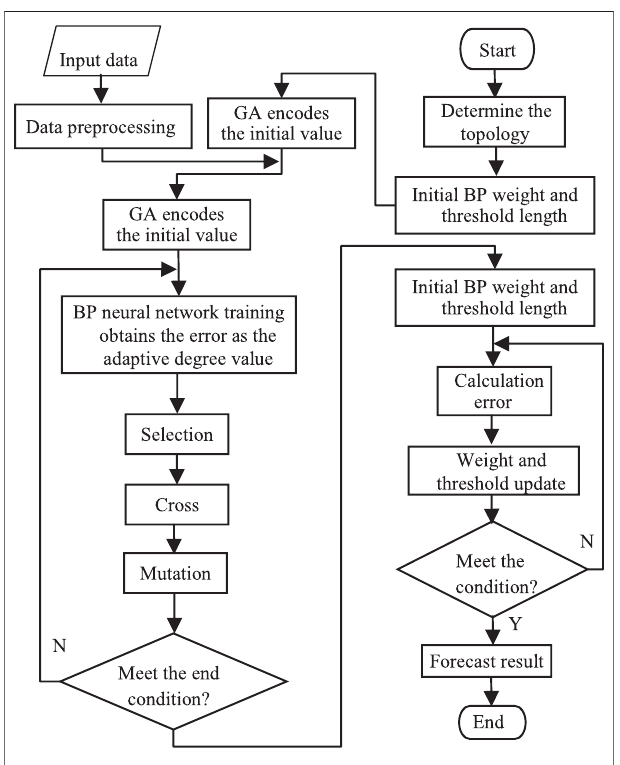
FIGURE 13 | General model of the BP neuron.